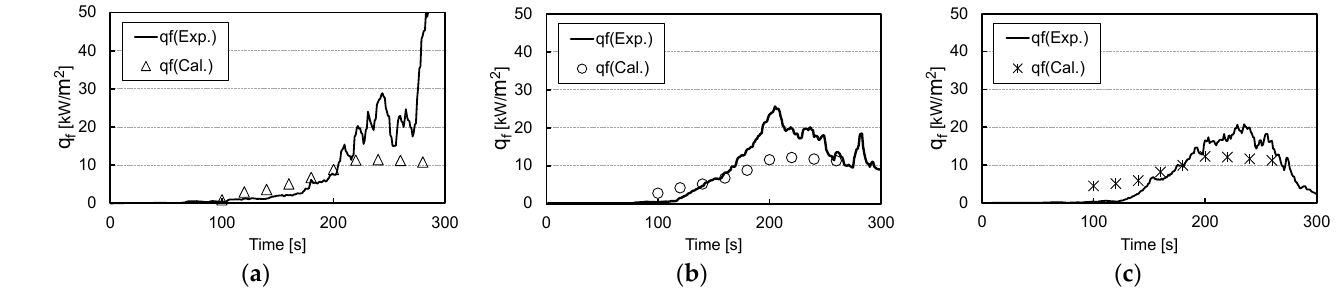
Figure 9. Comparison of calculated values by Mudan–Croce formula with the experimental values: ( a ) HB=0 mm; ( b ) HB=215 mm; ( c ) HB=515 mm.